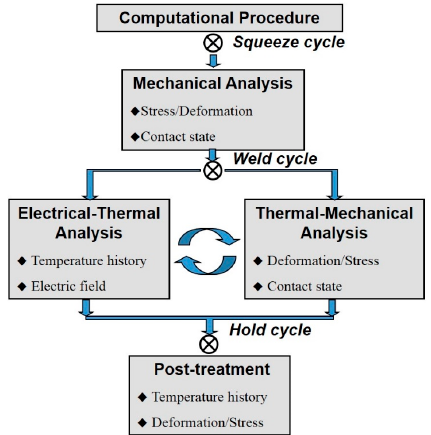
Figure 6. Computational procedure for finite element modeling of the weld-bonding